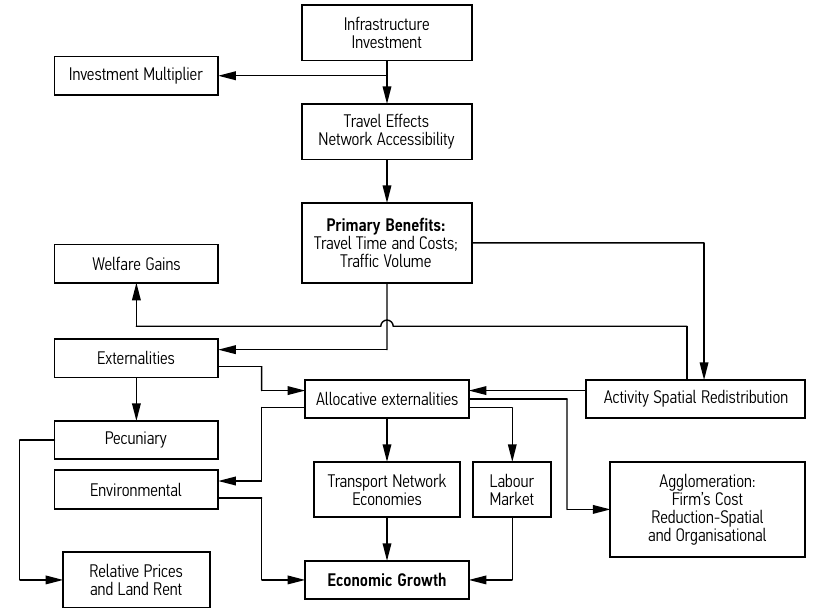
Fig. 3. Relationship of accessibility and economic growth (Banister, Berechman